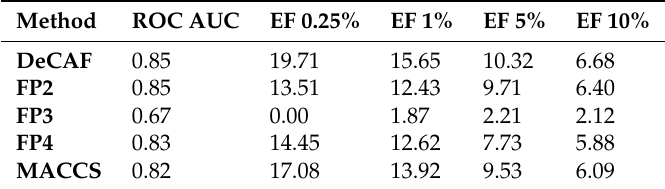
Table 1. ROC AUC and enrichment factors for DeCAF and four fingerprints. EF values were calculated for 0.25%, 1%, 5% and 10% of top ranked predictions.